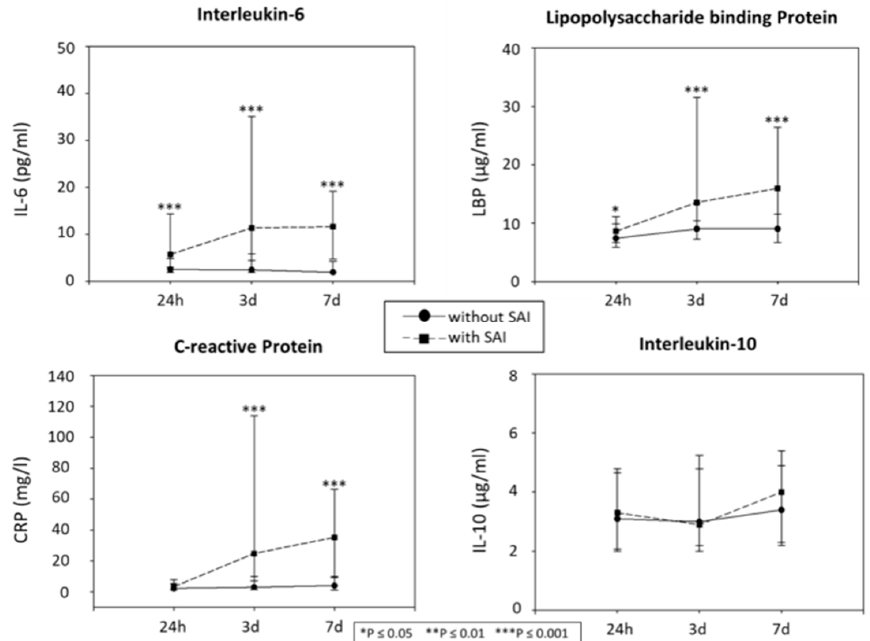
Figure 1. Temporal pattern of the biomarkers in patients with and without SAIs. Biomarker’s temporal pattern in patients with ( n = 44) and without infection ( n = 148). * indicates significant differences between the groups (* p ≤ 0.05; ** p ≤ 0.01; *** p ≤ 0.001). IL, Interleukin; LBP, lipopolysaccharide binding protein; CRP, C-reactive protein; h, hours; d, days; SAI, Stroke-associated infection.